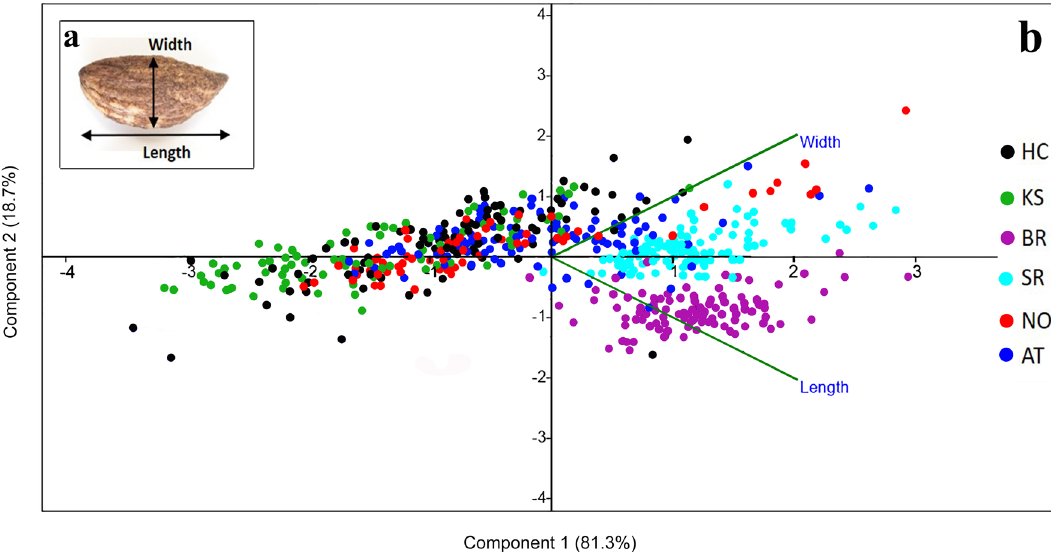
Figure 7. ( a ) Olive pit measurements taken. ( b ) Results of a principal component analysis (PCA) of the quantitative morphological traits: black Hishuley Carmel (HC) N = 100, green Kfar Samir (KS) N = 84,